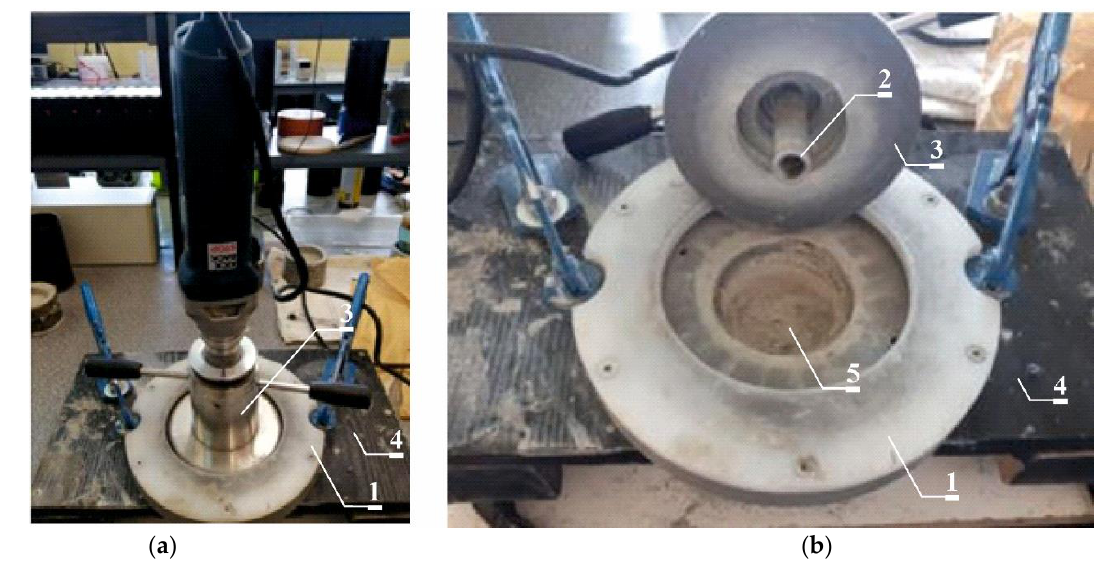
Figure 3. General view of the concrete grinding station ( a ), view of the samples from which the concrete material was ground ( b ). 1 - grinding support plate, 2 - high-performance grinding diamond bit, 3 - handle cover with flange and counter nut, 4 - station serves to hold the concrete sample, 5 - concrete sample while grinding its surface.